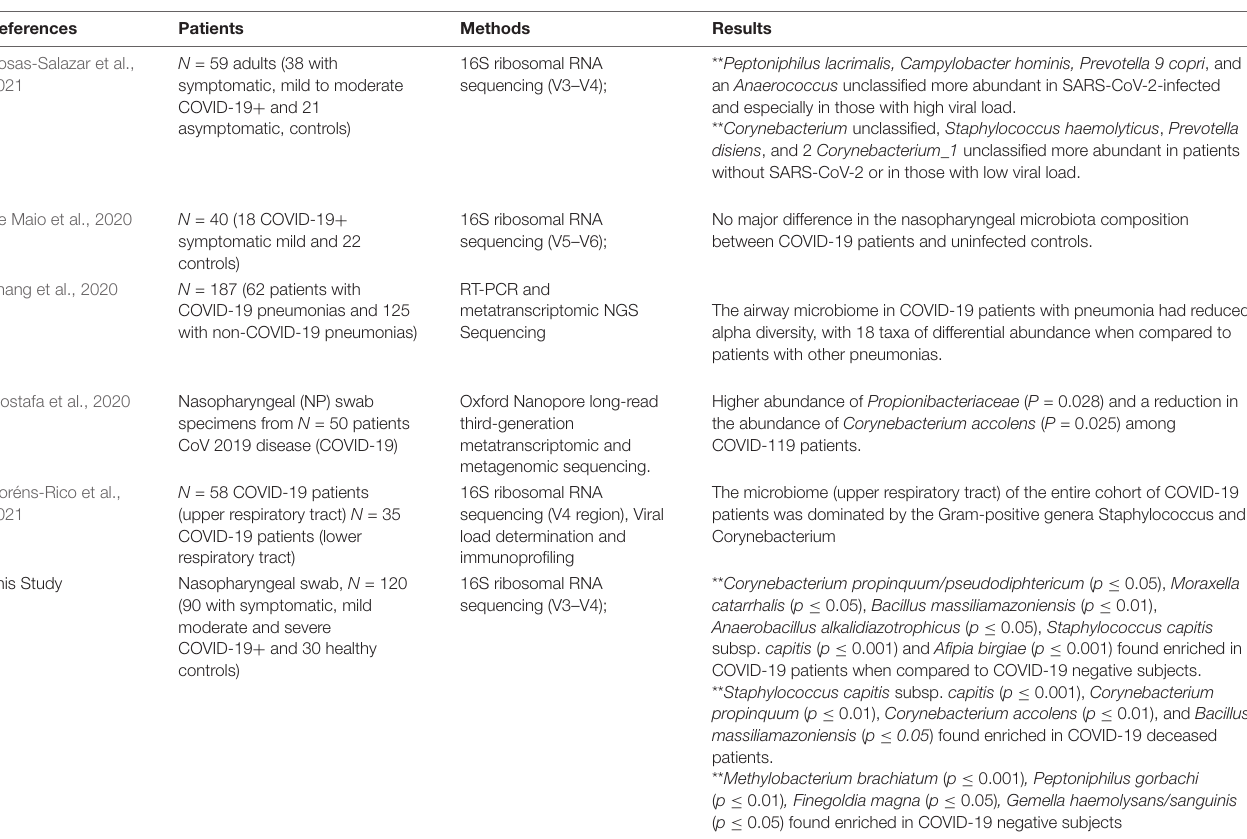
TABLE 2 | The predominant nasopharyngeal microbiota in COVID-19